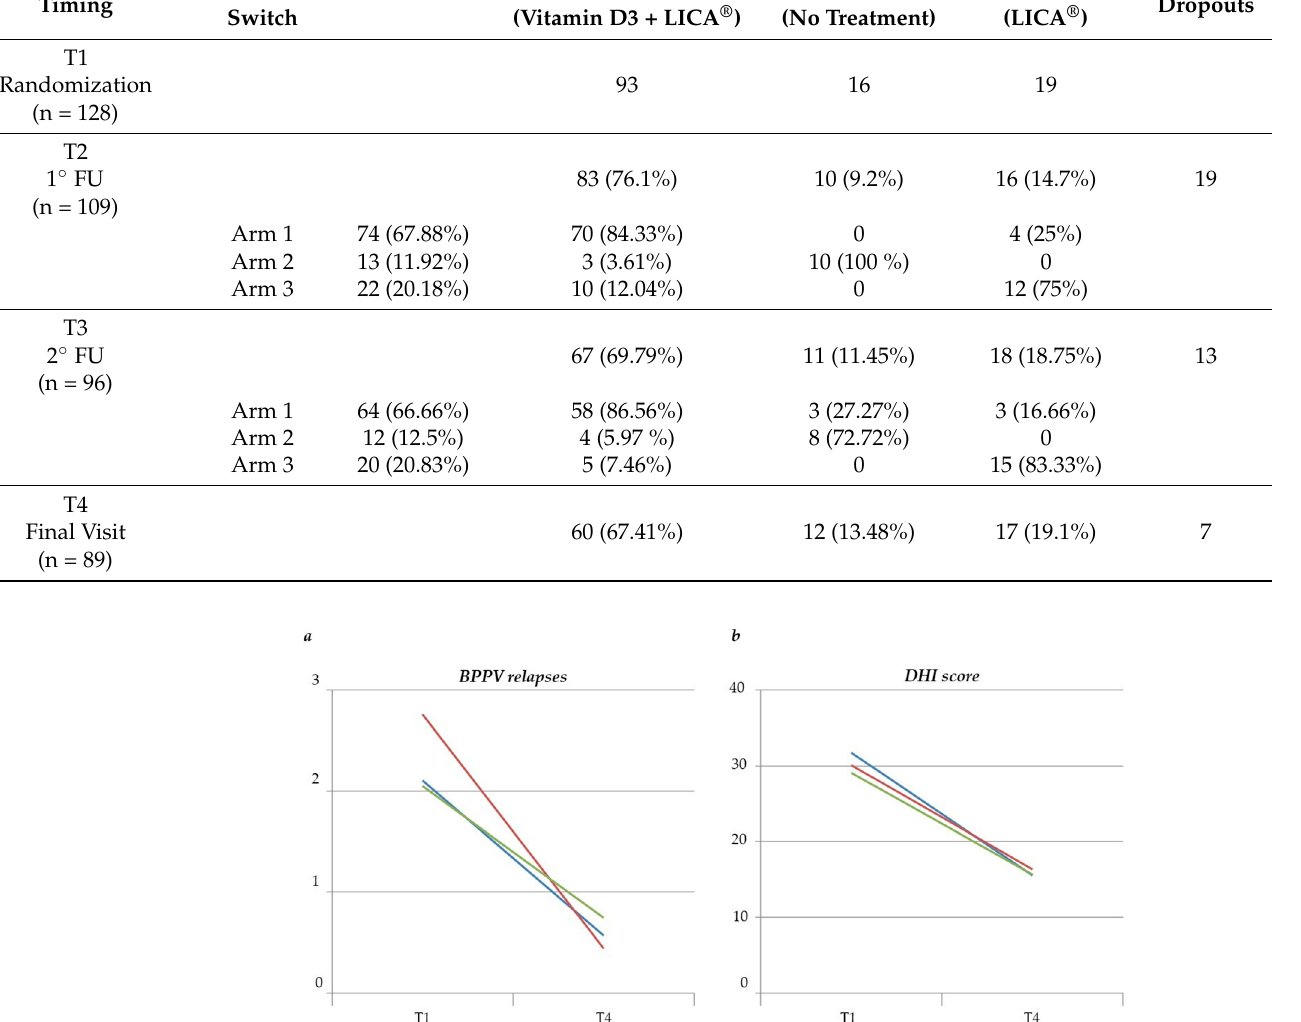
Figure 1. Variation of BPPV relapses ( a ) and DHI score ( b ) from randomization visit (T1) to the end of the study (T4). Red line: Arm 1, blue line: Arm 2, green line: Arm 3.